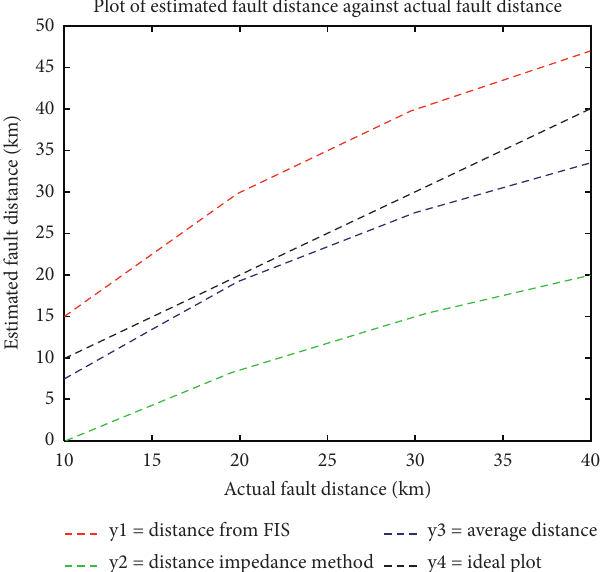
Figure 7: Plot of estimated fault distance versus actual fault dis- tance for overhead distribution system.